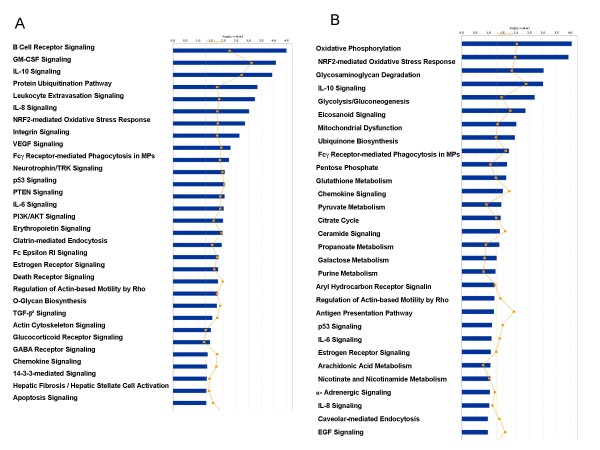
Panel A. Pathway analysis of differentially expressed MPD genes. Ingenuity pathway analysis showing canonical pathways significantly modulated by the genes whose expression differed among the MPD neutrophils compared to healthy subject neutrophils(p < 0.05). A total of 1,270 genes were differentially expressed: 473 were up-regulated and 800 were down-regulated. Only the 30 pathways with the most significant changes are shown. The p value for each pathway is indicated by the bar and is expressed as -1 times the log of the p value. The line represents the ratio of the number of genes in a given pathway that meet the cutoff criteria divided by the total number of genes that make up that pathway. Panel B. Pathway analysis of differentially expressed G-CSF genes. Ingenuity pathway analysis showing canonical pathways significantly modulated by the genes whose expression differed among the G-CSF-mobilized neutrophils compared to healthy subject neutrophils (p < 0.05). A total of 909 genes were differentially expressed: 452 were up-regulated and 457 were down-regulated. Only the 30 pathways with the most significant changes are shown. The p value for each pathway is indicated by the bar and is expressed as -1 times the log of the p value. The line represents the ratio of the number of genes in a given pathway that meet the cutoff criteria divided by the total number of genes that make up that pathway.